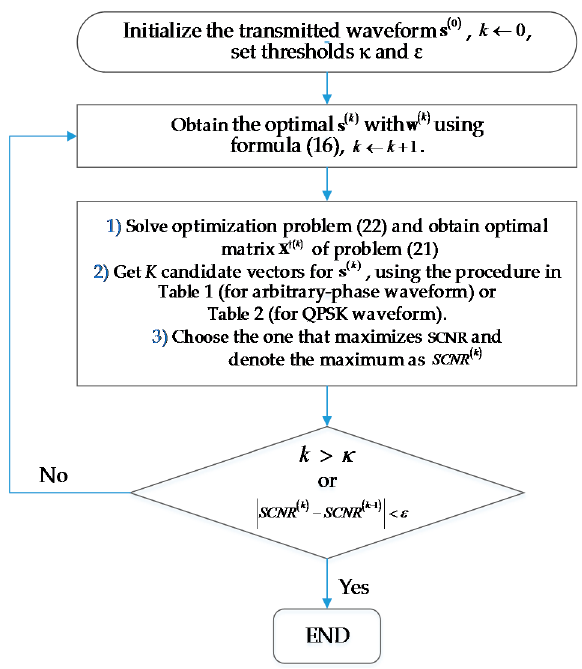
Figure 2. Flowchart of the proposed iterative constant-modulus waveform design methods.